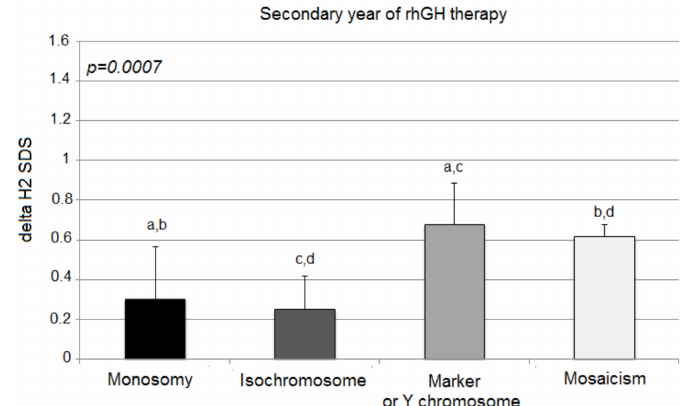
Figure 2. Growth response to rhGH during the second year of therapy. H2 SDS, height standard deviation score after 2 years of therapy; the ANOVA test was applied ( p < 0.001). Values (bars) marked with the same letters are significantly different (Dunn’s multiple comparisons test): a— p < 0.04; b— p < 0.032; c— p < 0.015; d— p < 0.012. The groups designed with the same letter different